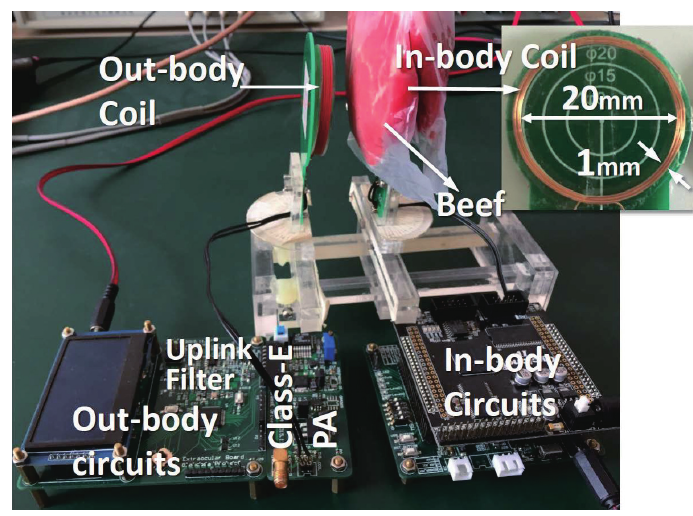
Figure 10. The prototype system was implemented to setup the measurements of power and bi-directional data transmissions with beef tissue.